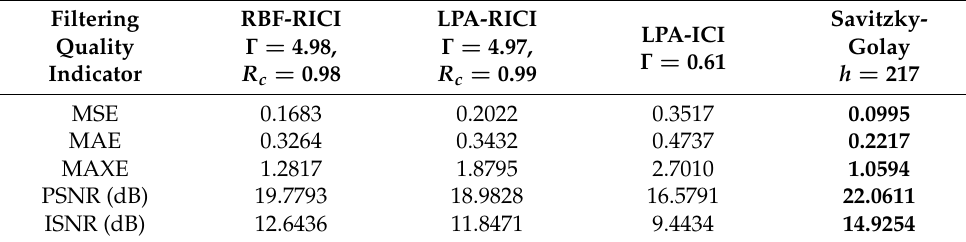
Table 22. HeaviSine signal (SNR = 5 dB)—Filtering results.